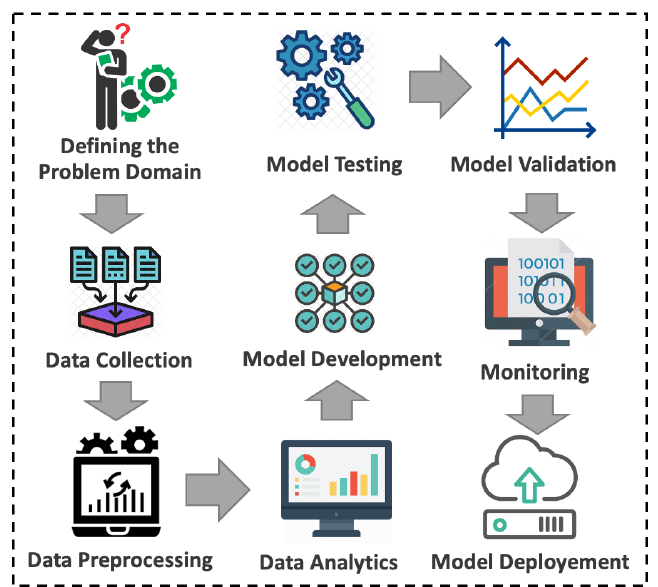
Figure 1. The abstract time-series forecasting